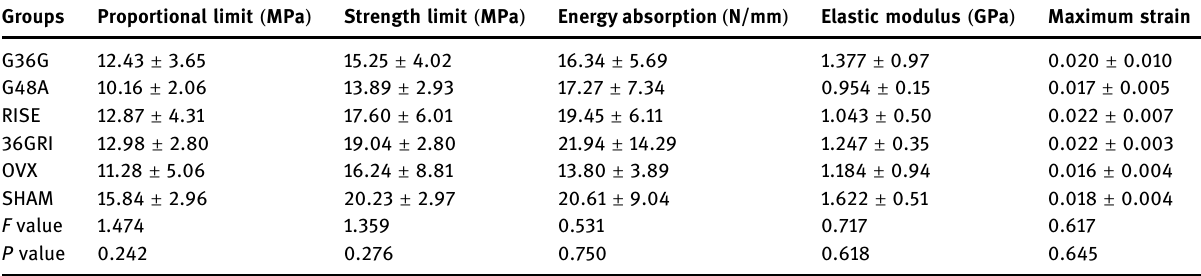
Groups Proportional limit ( MPa )